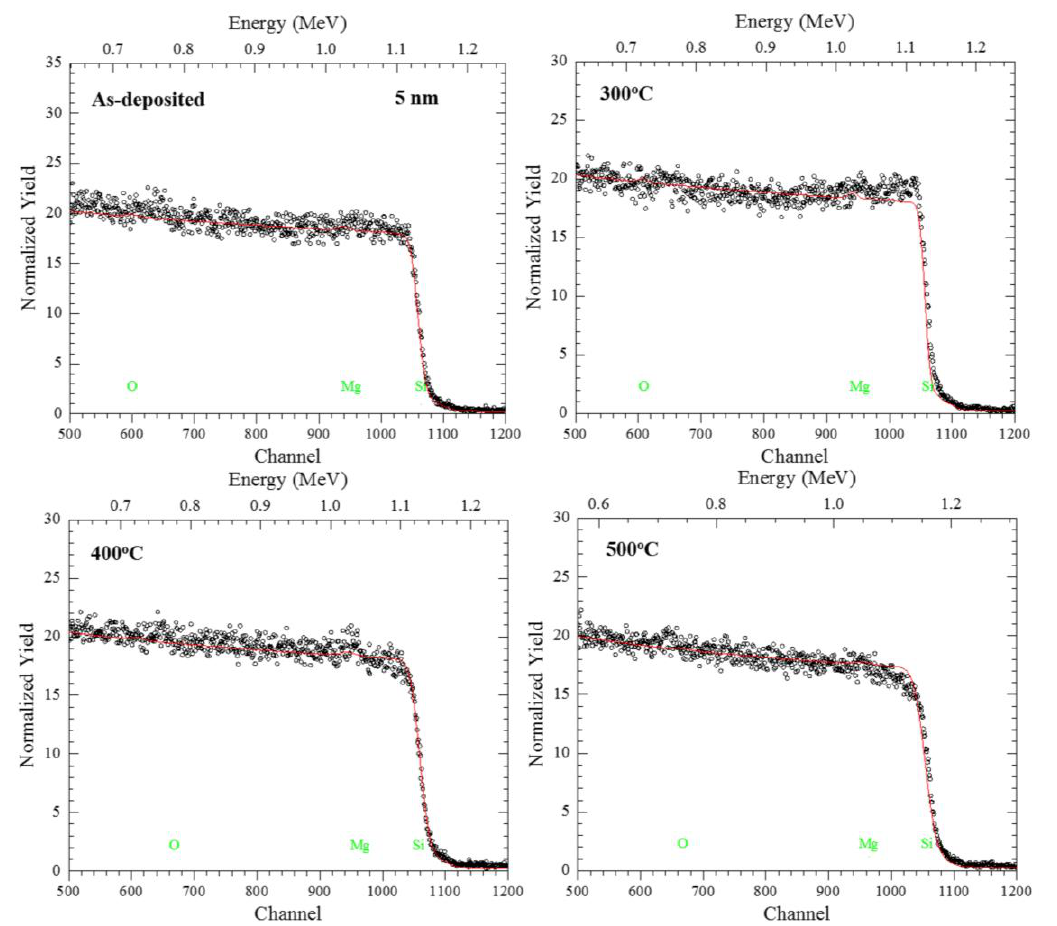
Figure 2. Experimental (open circles) and simulated (red line) RBS spectra of as-deposited thin film of thickness 5 nm annealed at 300, 400 and 500 o